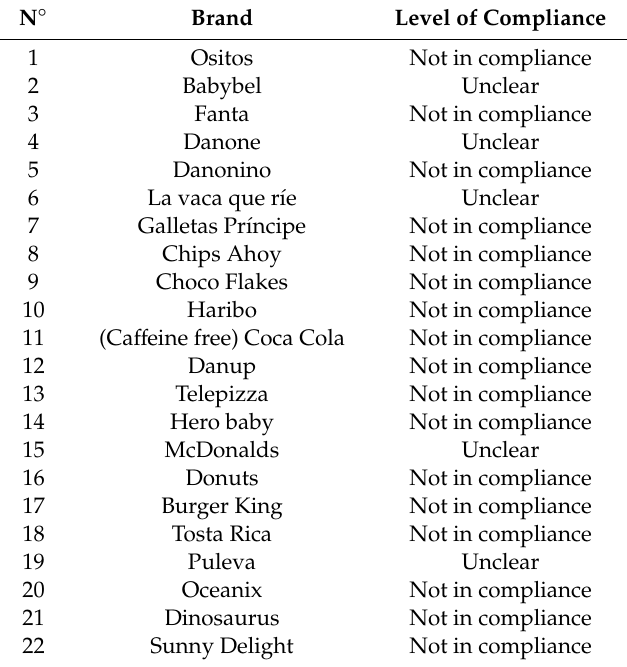
Table 3. PAOS Code compliance / not